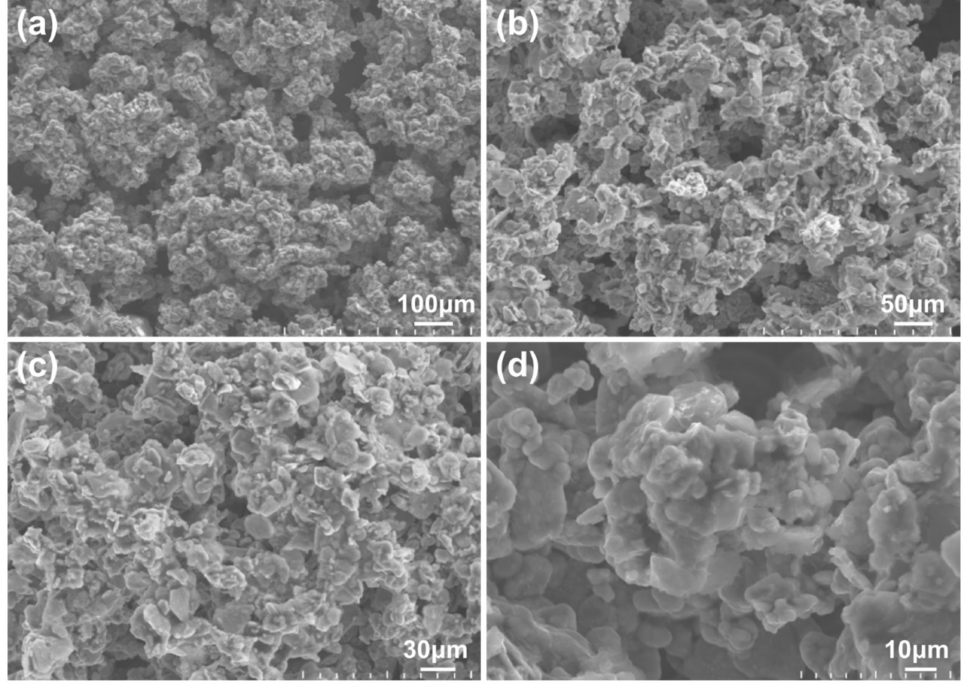
Figure 2. The SEM images of the Ni-Co/WS 2 nanocomposite coatings at different magnifications: ( a ) 500 times; ( b ) 1000 times; ( c ) 1500 times; ( d ) 4000 times. The parameters for DC electrodeposition: current density, 3 A/dm 2 ; deposition time, 50 min; WS 2 concentration, 10